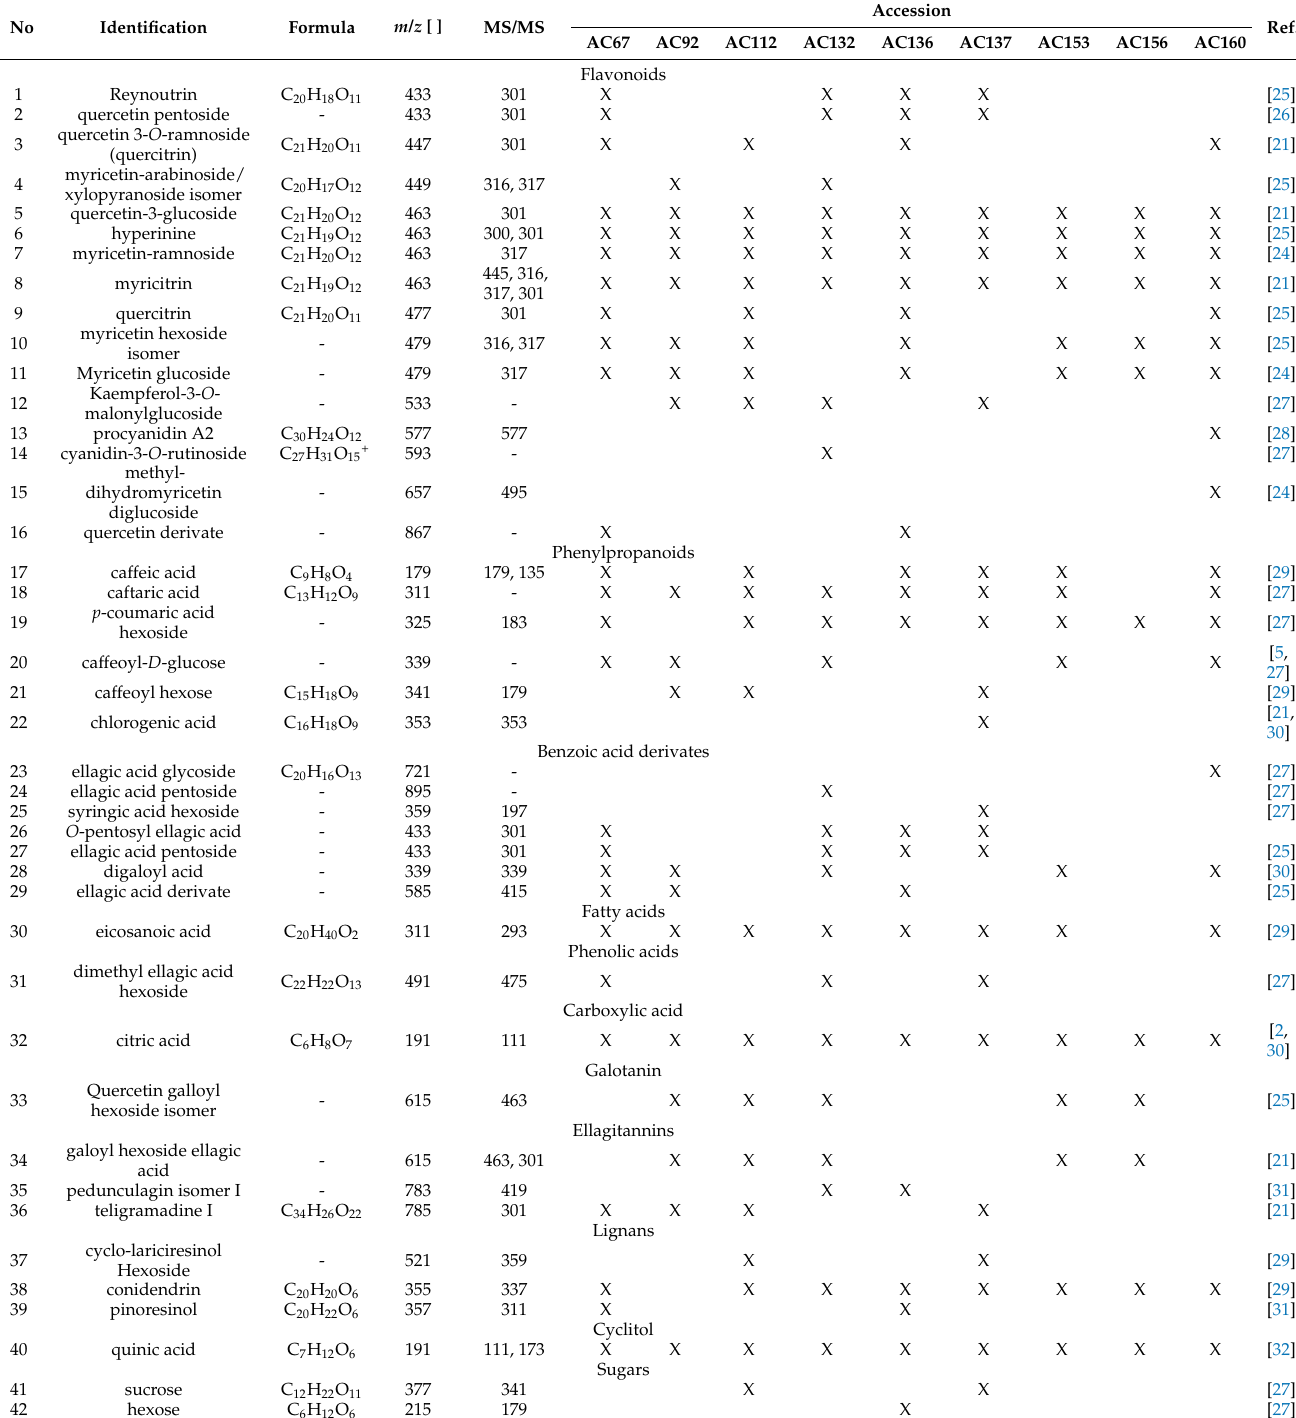
Table 4. Chemical profile of Myrciaria floribunda fruits identified by PS-MS on negative ionization